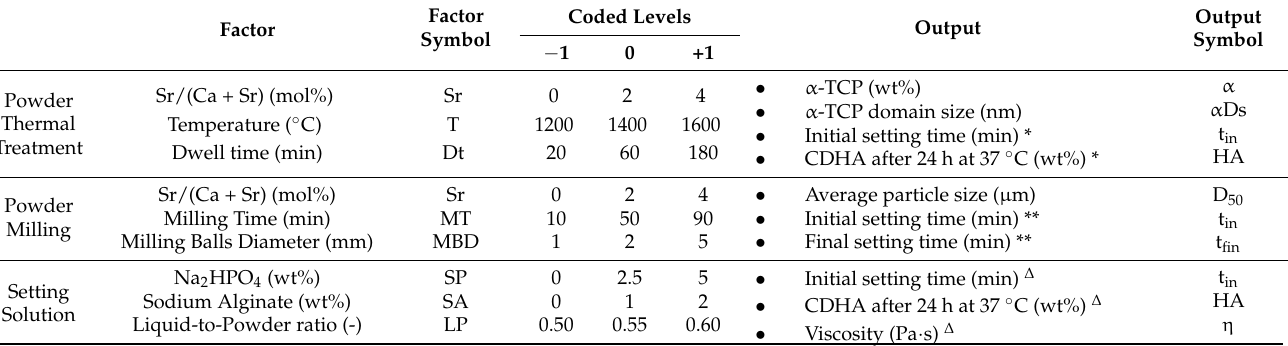
Table 1. Input factors and correspondent coded